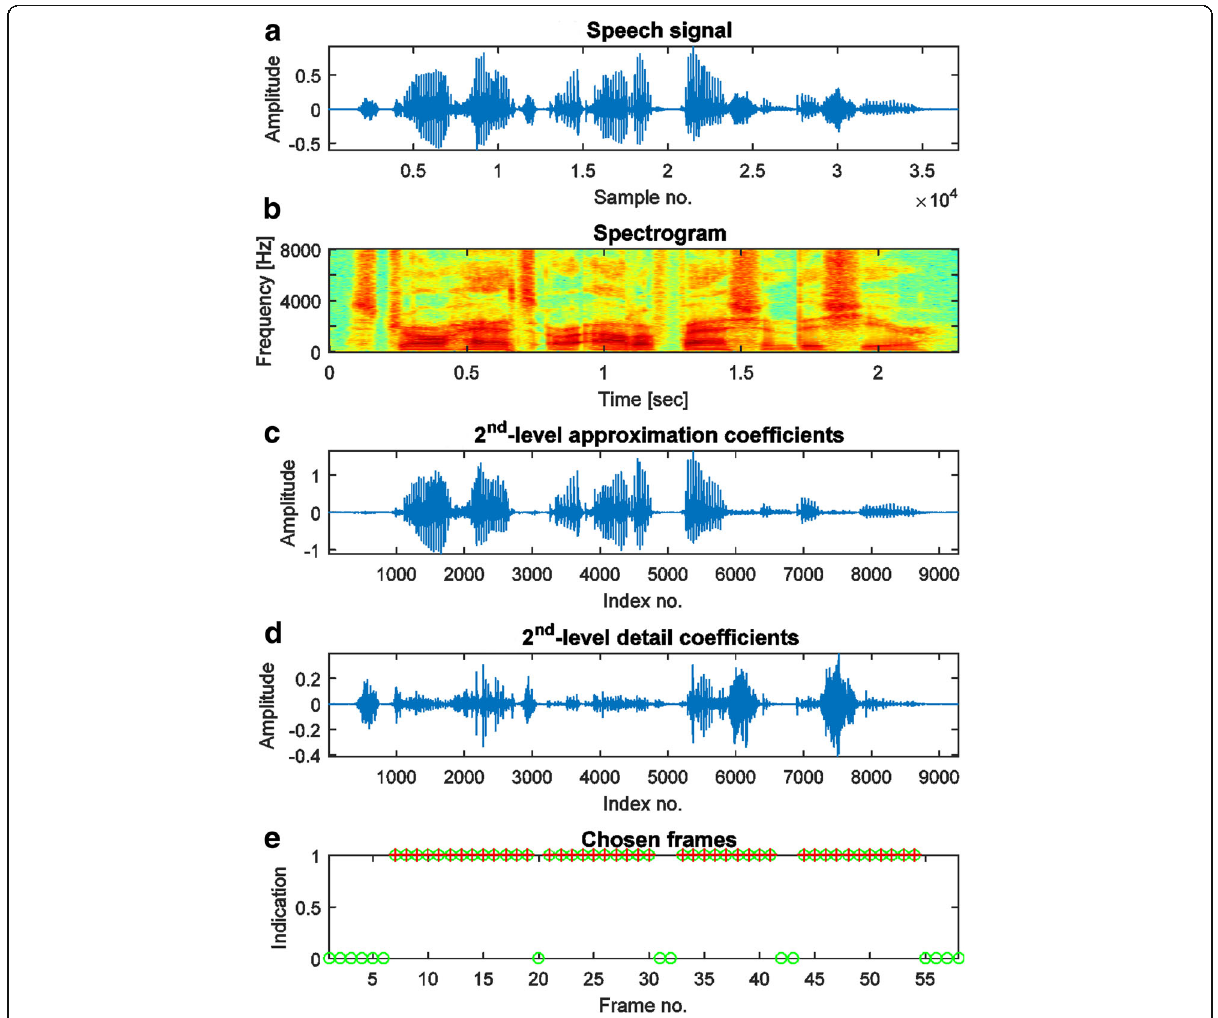
Fig. 1 a – e Illustration of searching for embedding frames. The embeddable frames are indicated by symbol “ ⨁